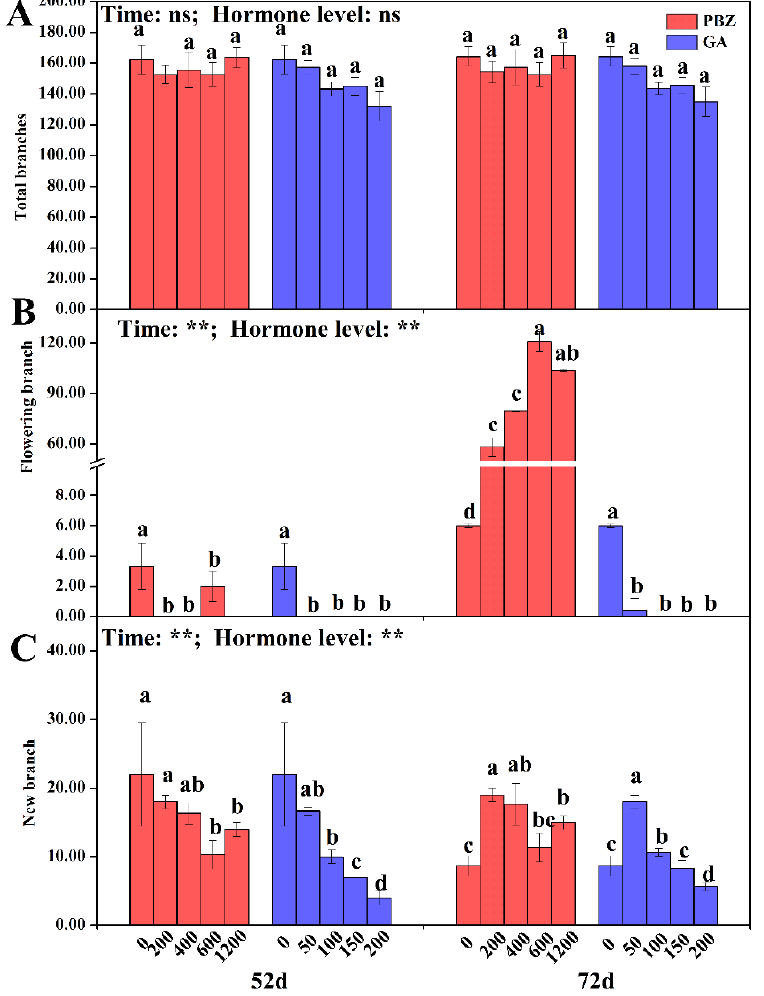
Figure 2. Effects of hormone regulation on types of lemon total ( A ), flowering ( B ), and new branches ( C ). Different letters (a, b, c and d) denote significant differences based on a p value < 0.05. ** denotes extremely significant difference ( p < 0.01).